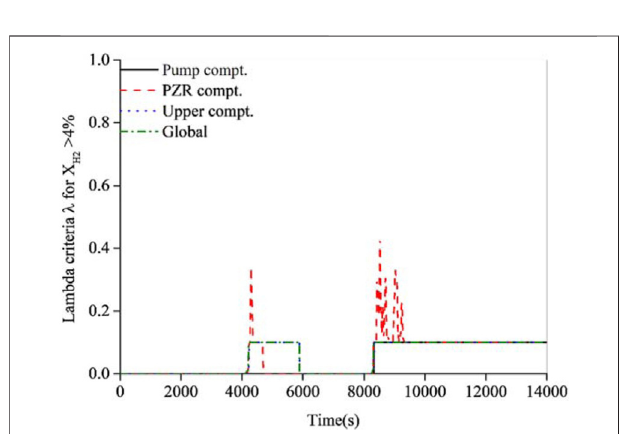
FIGURE 7 | The λ criteria for hydrogen cloud (X H2 > 4 vol%) in major